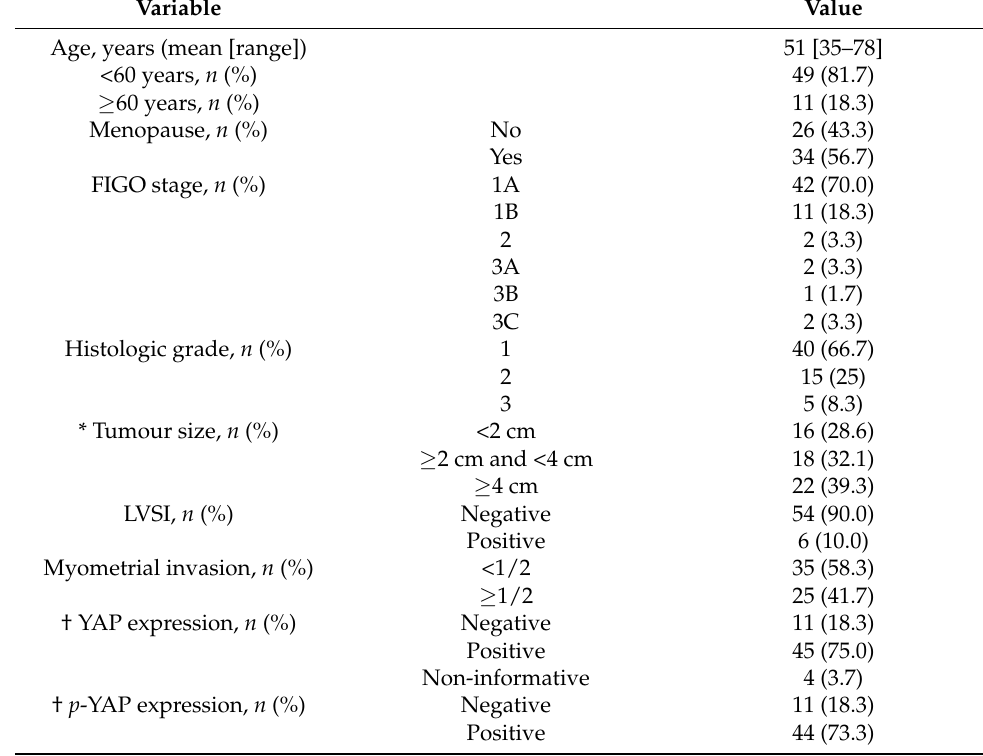
Table 1. Clinicopathological features in patients with endometrial cancer ( n =